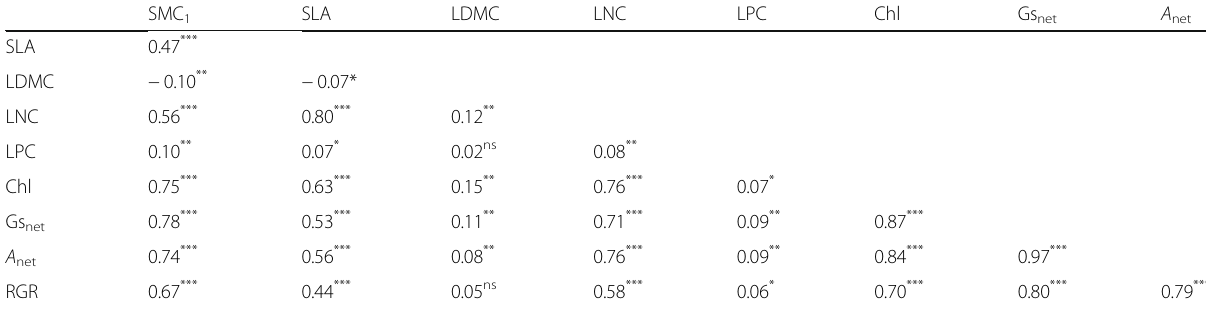
Table 5 Pearson correlation coefficients between SMC 1 and functional attributes across species, sites, seasons, and light levels